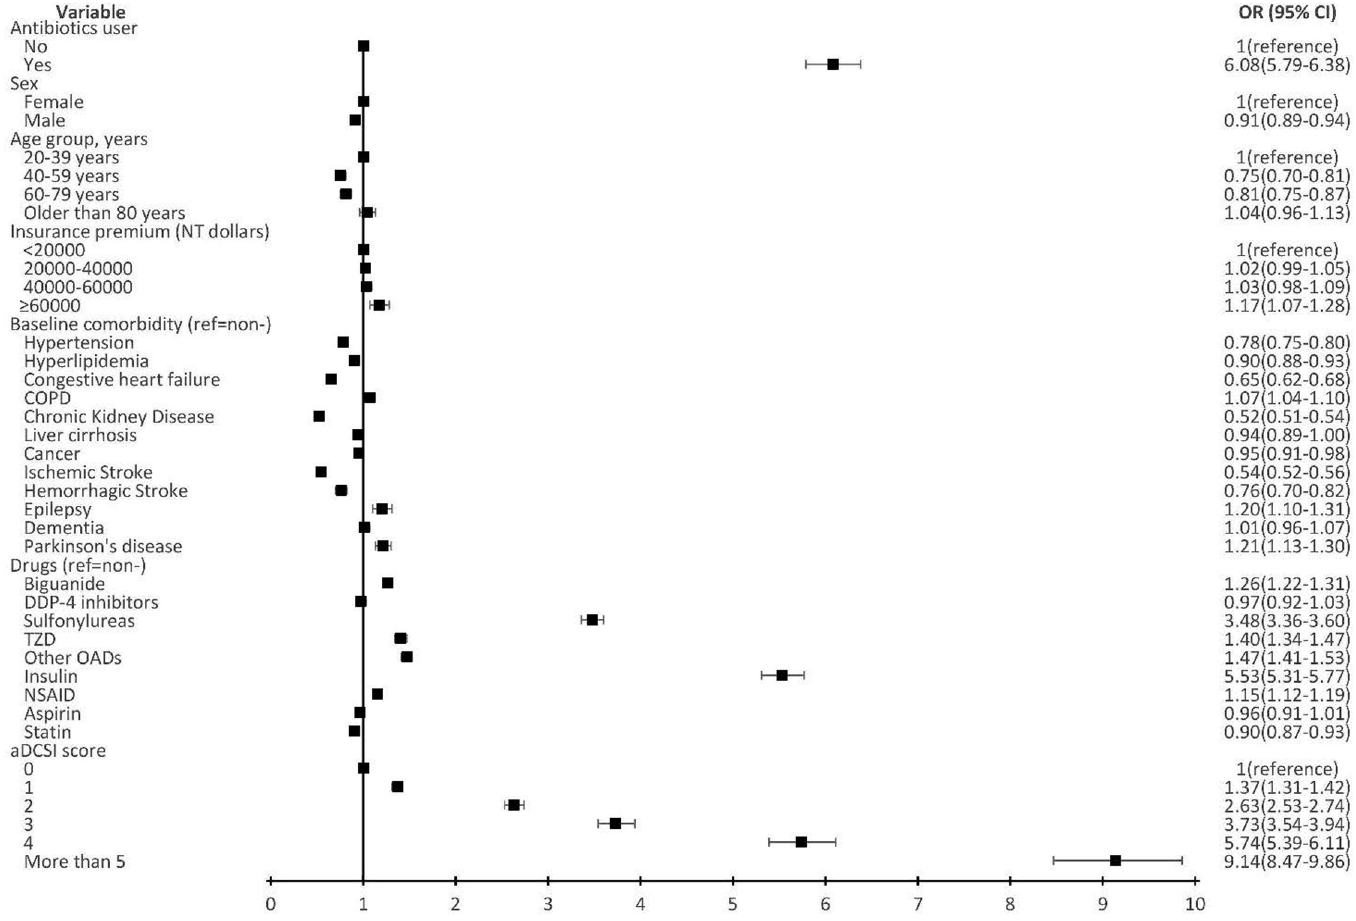
Fig 2. Logistic regression model to evaluate the risk for hypoglycemic emergency. OR: Odds ratio, CI: 95% Confidence Interval. The black boxes denote the ORs.